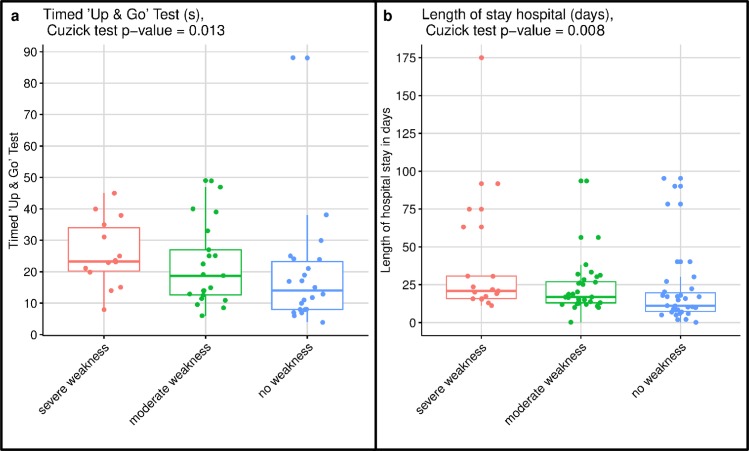
Illustration of the Timed ‘Up & Go’ test and hospital length of stay per MRC-SS group.Illustration of the Timed ‘Up & Go’ test (a) and hospital length of stay after ICU discharge (b) with non-parametric Cuzick test clearly rejecting the null hypothesis in favour of alternative: values for severe weakness > no weakness and severe weakness ≥ moderate weakness ≥ no weakness.